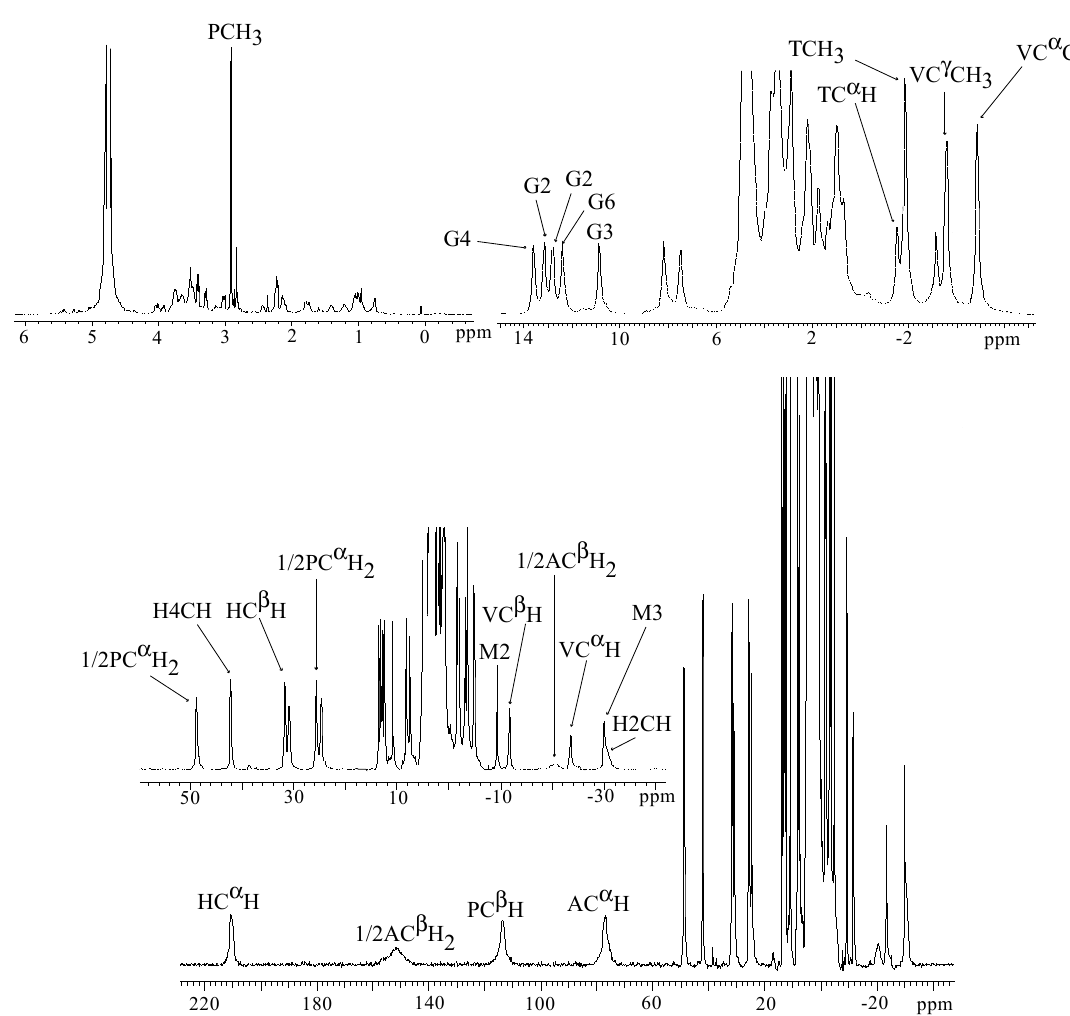
Figure 8. 1 H-NMR spectrum of Co(II)BLM [48].